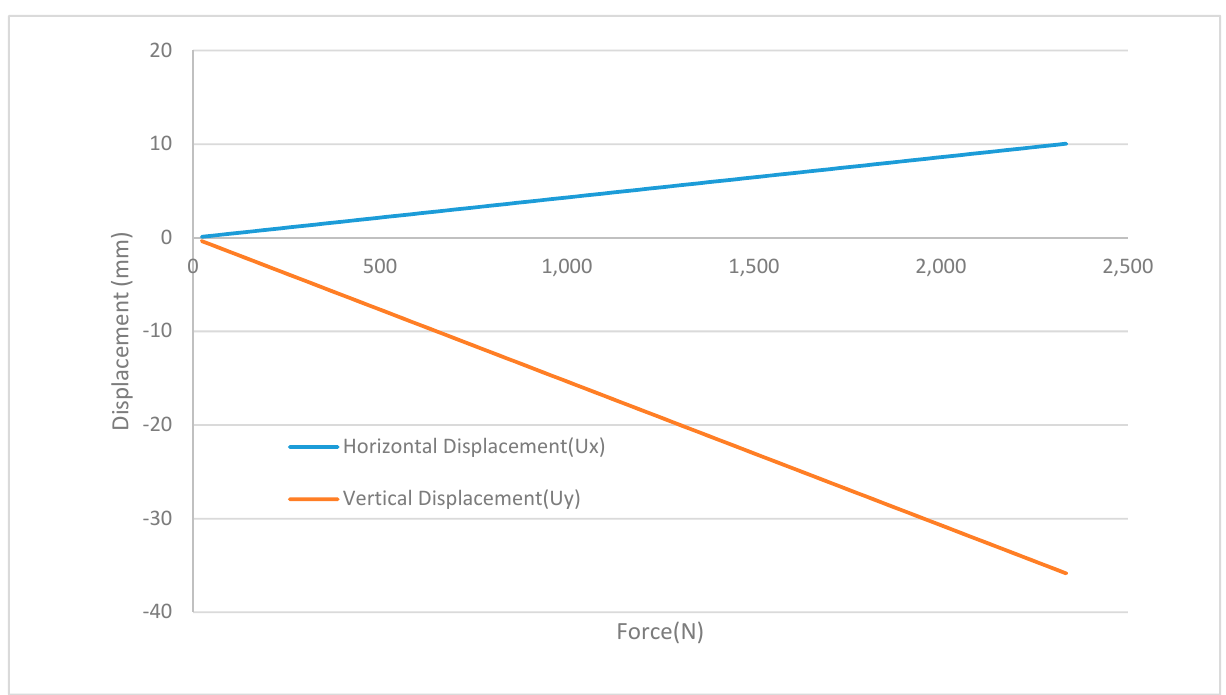
Figure 18. Horizontal and vertical displacements at node 20, element 1126 with coordinate details: ( x = 0, y = 0.25, z = − 4) and 0% FA.